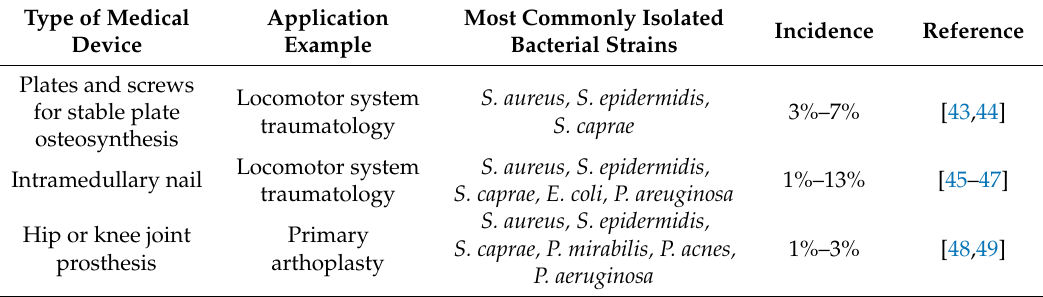
Table 1. Selected peri-implant